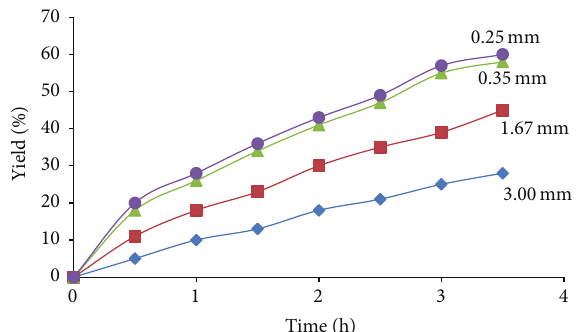
Figure 13: The effect of particle dimension on the reaction efficiency [12].